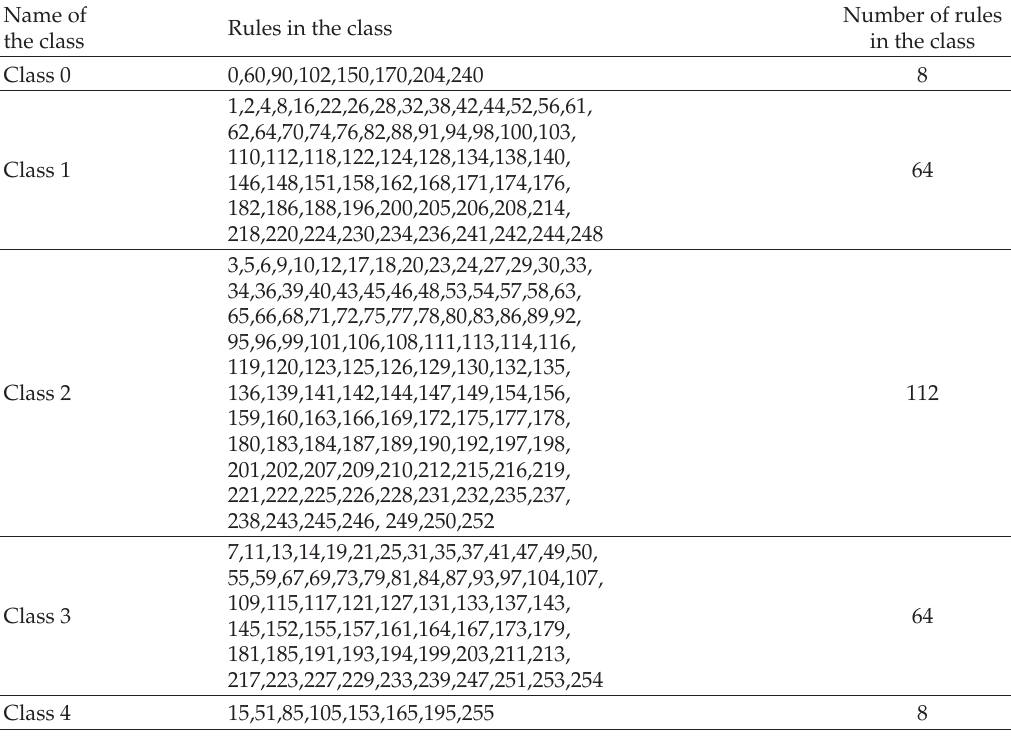
Table 2: Classification of three-variable Boolean rules.